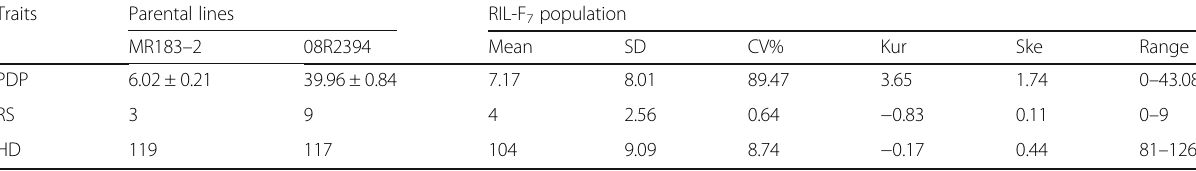
Table 2 Variations in disease phenotype and heading date of parental lines and the RIL-F 7 lines Traits